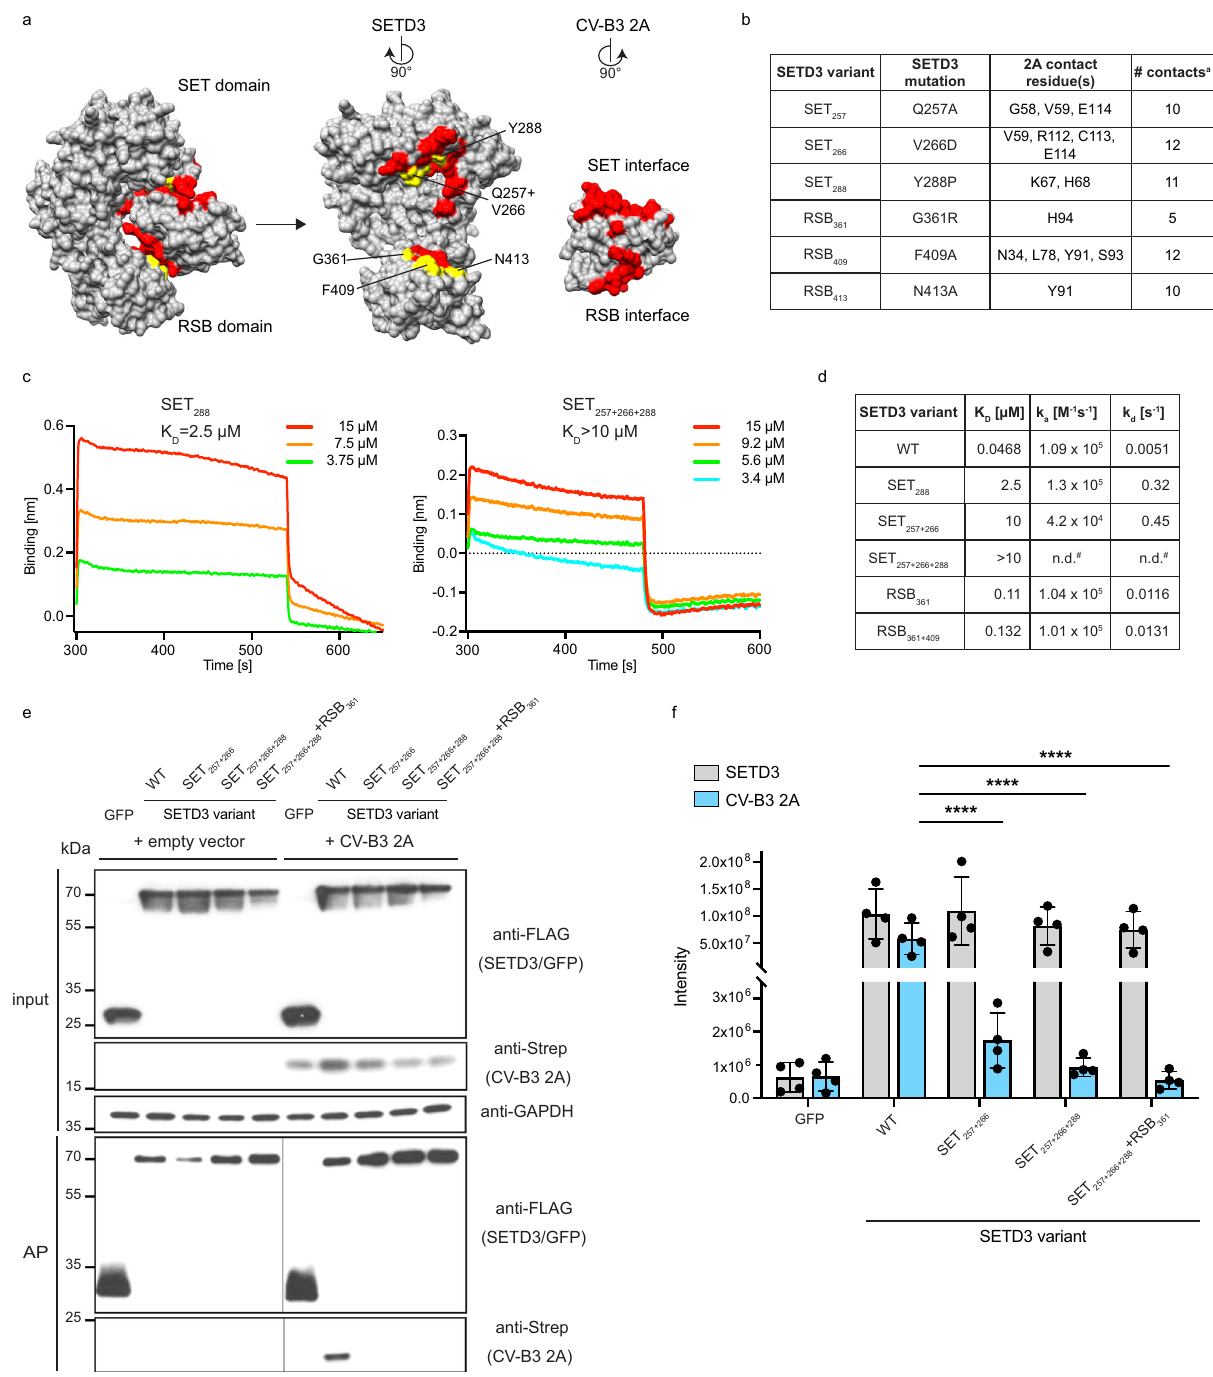
Fig. 3 | TheSET interfaceiscriticalfor 2A binding.a Surface view of the binding interface and the selected mutants for functional validation. Residues making up the interaction interface on SETD3 and 2A are labelled in red. Residues on SETD3 mutated for further analysis are indicated in yellow. See also Supplementary Table2. b Characteristicsofthe residuesselectedformutations. a Contactde fi ned as <4.1Å. See also Supplementary Table 2. c , d In vitro biolayer interferometry binding assay results for puri fi ed SETD3 variants to 2A protein. See also Supple- mentary Fig. 5. c Binding curves for varying input concentrations (different col- ours indicated in legend to individual plots) of selected SETD3 variants. Equilibrium constants K D as calculated by the integrated software of the Octet RED384 instrument are shown. d Summary table of in vitro binding assay. Rate constants and equilibrium constants were determined using the integrated software of the Octet RED384 instrument. n.d. not determined; # Binding curves